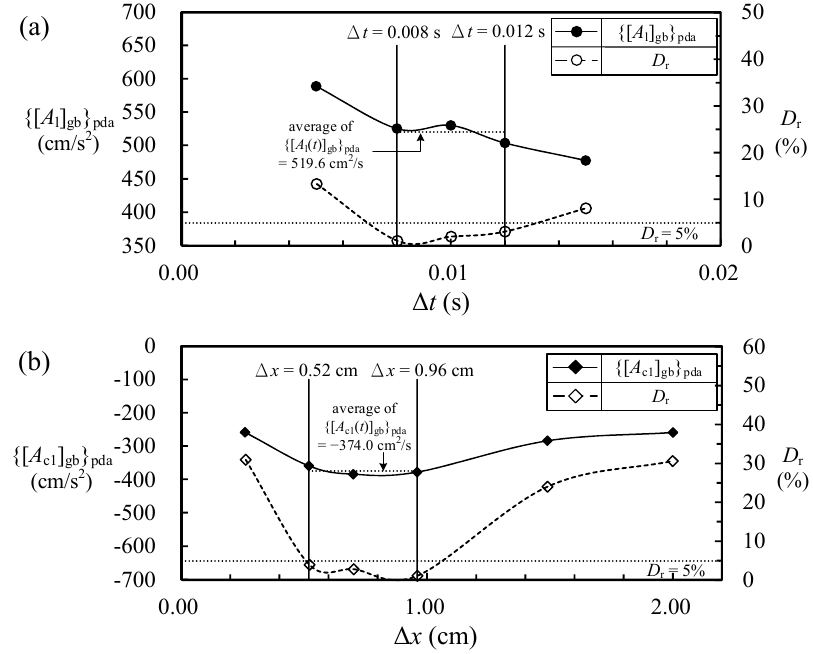
Figure A2. Computed results and relative deviations for values of ( a ) local acceleration {[ A l ] gb } pda ; and ( b ) first convective acceleration {[ A cl ] gb } pda at t = 2.069 s. Promising range of ∆ t or ∆ x , within which relative deviation D r of each result of either {[ A l ] gb } pda or {[ A cl ] gb } pda varies only within 4.0% with reference to conditional average, is marked between two vertical lines.